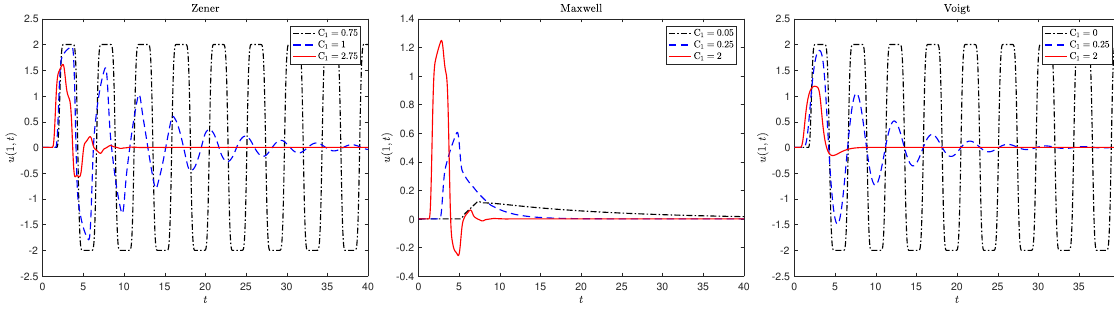
Fig. 2 Effect of changing C 1 using the parameters given in Table 1.